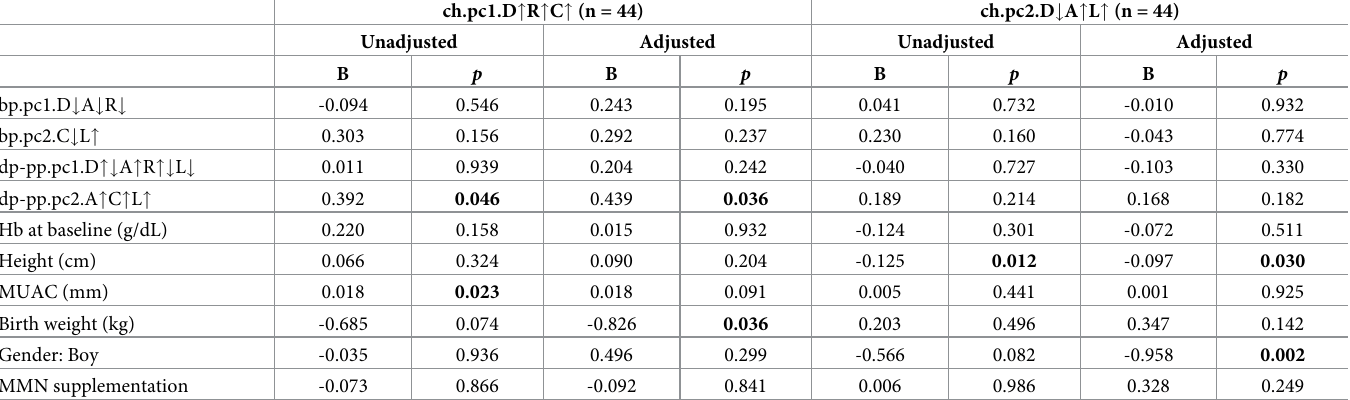
Table 6. Association of maternal components and child characteristics with child biomarker